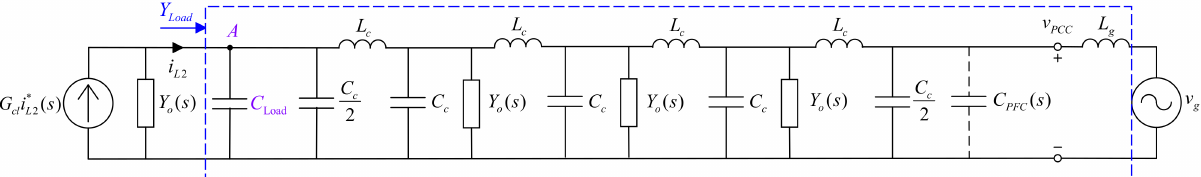
Figure 21. Admittance-based equivalent circuit of Figure 20